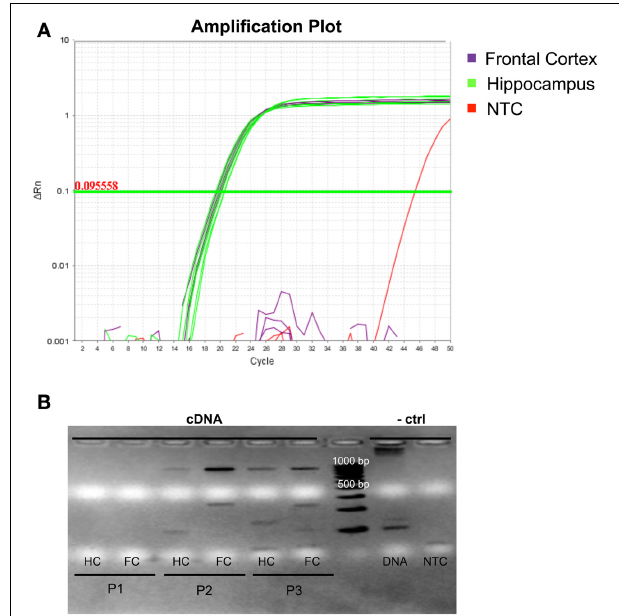
FIGURE 3 | Expression profile of hsa-miR-138-5p and DCP1B in autopsy brain tissues of three deceased human probands. (A) Amplification plot of qPCR experiments in three frontal cortices (highlighted in purple) and three hippocampi (highlighted in green). Hsa-miR-138-5p was expressed in both frontal cortex (FC) and hippocampus (HC; C T ∼ 19). One of two NTCs (non-template control, highlighted in red) showed amplification at C T > 45, whereas theother NTCdidnot show anyamplification. (B) Ethidiumbromide stained gel electrophoresis in 1% agarose displays the semi-quantitative levels of DCP1B cDNA (expected and observed at ∼ 850bp) in post-mortem human brain tissues. No expression was detected in proband 1 (P1). The DCP1B cDNA levels were higher in the FC, compared to HC of proband 2 (P2) and proband 3 (P3). (A) gDNA amplicon band (expected and observed at ∼ 6.9kb) could be detected and no band in the